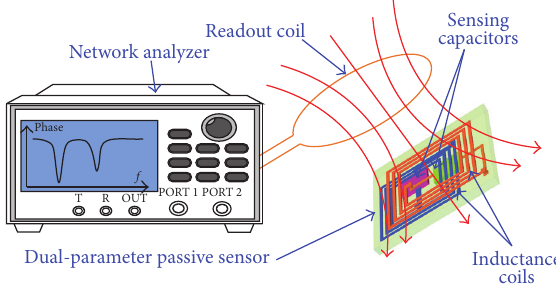
Figure 1: Schematic of dual-parameters 𝑅𝐹 readout by a 𝐿𝐶 -type passive sensor.